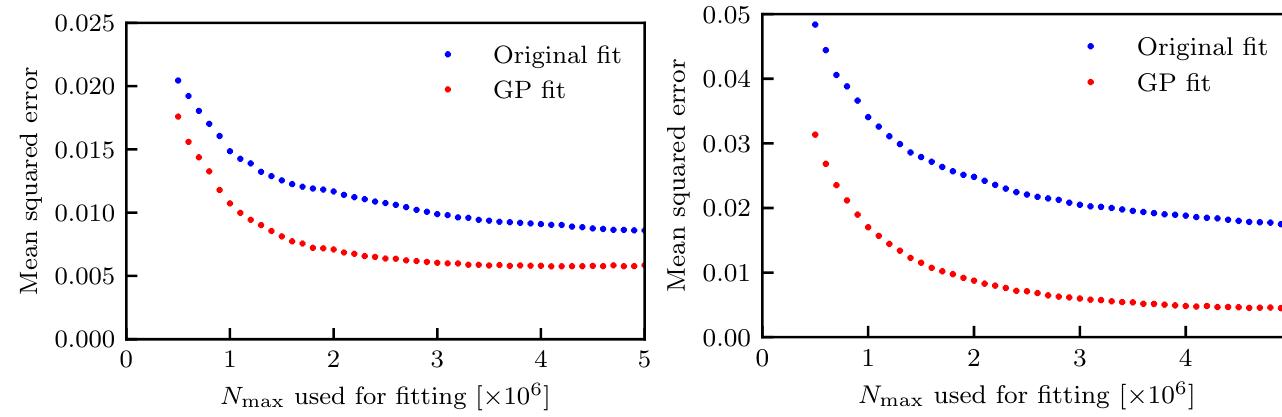
Figure 11. Evolution of the MSE as a function of N max used in the fit of the DA model (14b). The curves refer to the original fit, with only numerical data, or to the fit including GP-generated synthetic points. The fit with three and two parameters are shown in the left and right plots, respectively (note the difference in vertical scale for the two